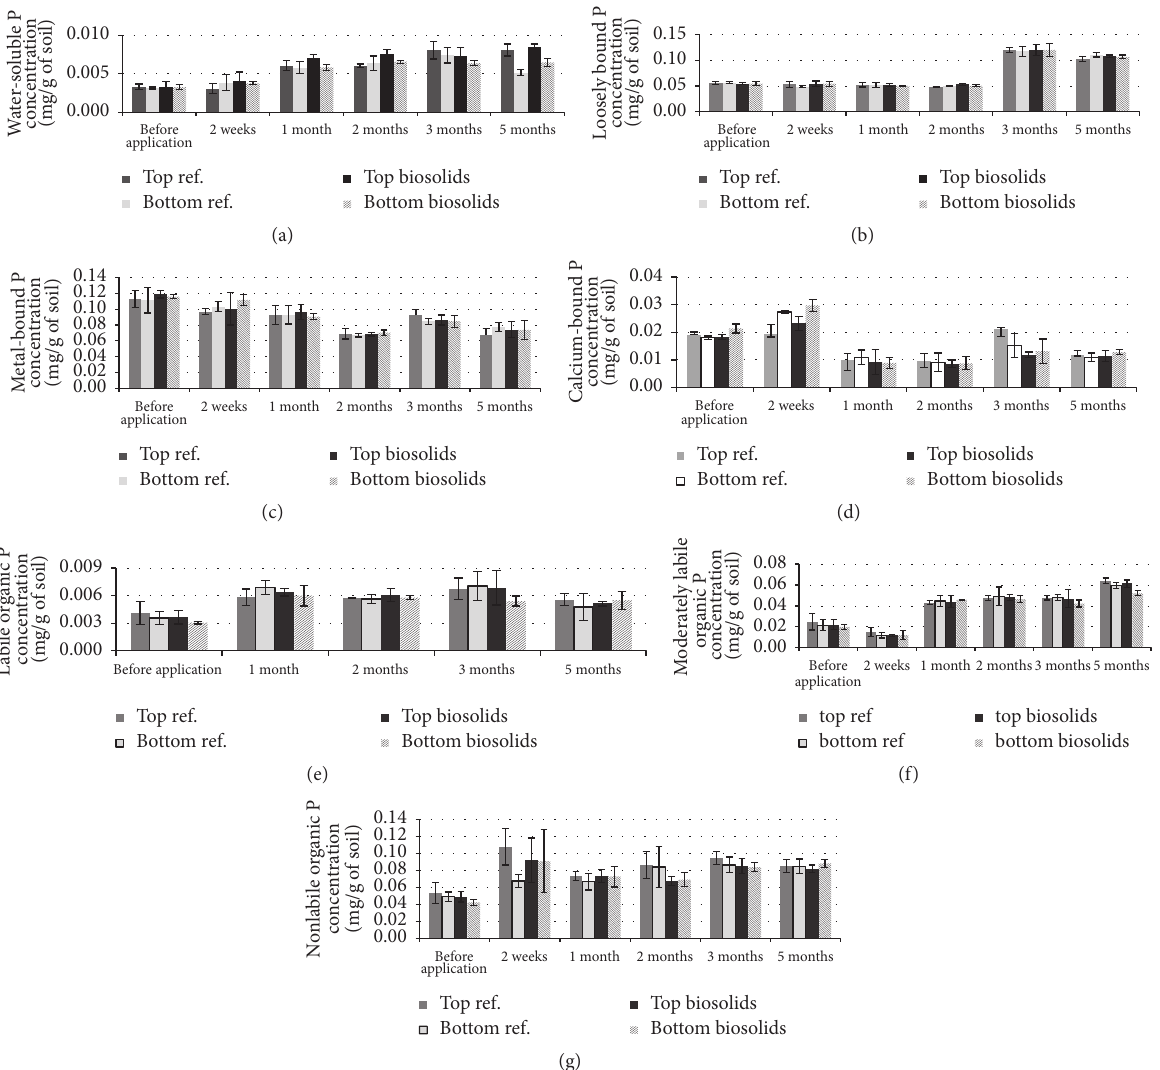
Figure 2: Phosphorus (P) fractions in soil measured in the reference and biosolids treated soil columns: a) inorganic water-soluble P, b) inorganic loosely bound P, c) inorganic metal-bound P, d) inorganic calcium-bound P, e) organic labile P, f) organic moderately labile P, and g) organic nonlabile P. The error bars represent standard deviation among replicate